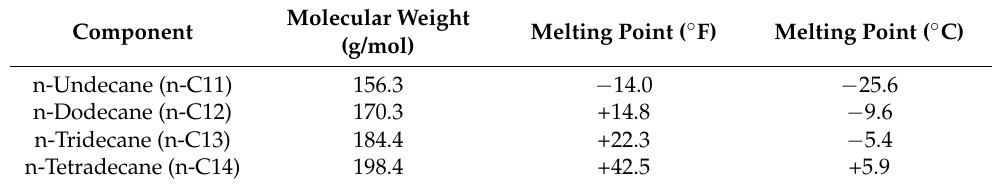
Table 2. Molecular weights and melting points of heavy hydrocarbons n-C 11 through n-C 14 [3].